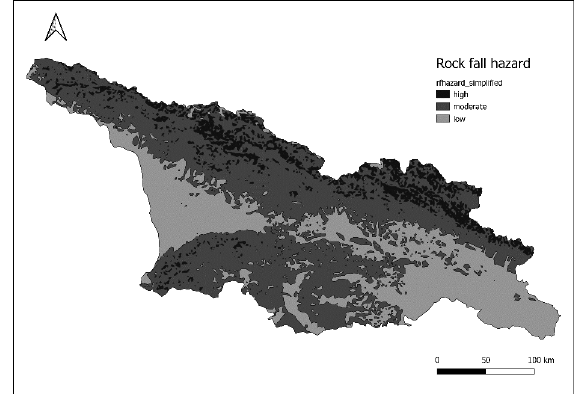
Figure 5. Rock fall